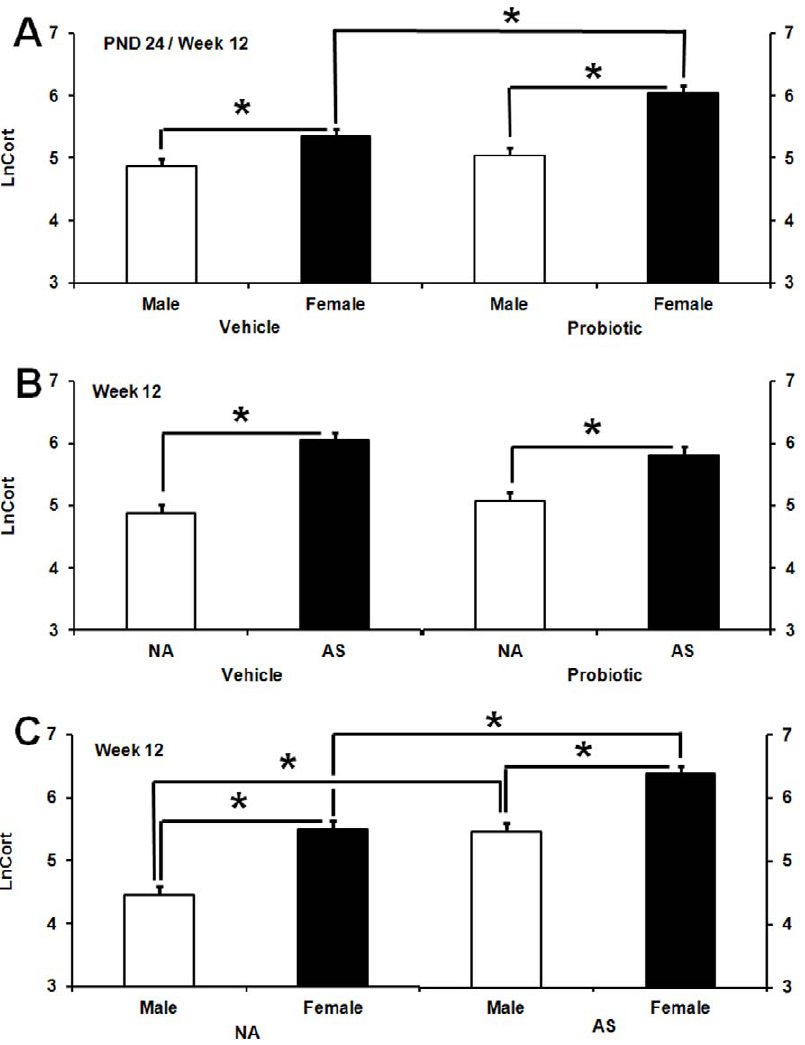
Figure 3. Effect of maternal probiotics, stress and gender on adult corticosterone levels. A ) Effect of maternal probiotic intervention and sex on natural log (Ln) transformed plasma corticosterone levels (LnCort, least squares means + SE). Initial corticosterone data were expressed as ng/ mL plasma. The figure presents aggregated data across test days (PND 24 and 86). Hollow bars represent males: male vehicle (n=71), male probiotic (n=53). Filled bars represent females: female vehicle (n=62), female probiotic (n=58). B ) Effect of maternal probiotic intervention and adult restraint stress on Ln-transformed plasma corticosterone concentrations (LnCort, least squares means + SE) in adulthood (week 12).Hollow bars represent animals exposed to no-stress in adulthood (NA): NA vehicle (n=39), NA probiotic (n=35). Filled bars represent animals exposed to stress in adulthood (AS): AS vehicle (n=39), AS probiotic (n=36). C ) Effect of adult restraint stress and sex on Ln-transformed plasma corticosterone concentrations (LnCort, least squares means + SE) in adulthood (week 12). Hollow bars represent males: NA male (n=35), AS males (n=36). Filled bars represent females: NA females (n=39), AS females (n=39). An asterisk (*) indicates statistical significant difference ( p # 0.05).